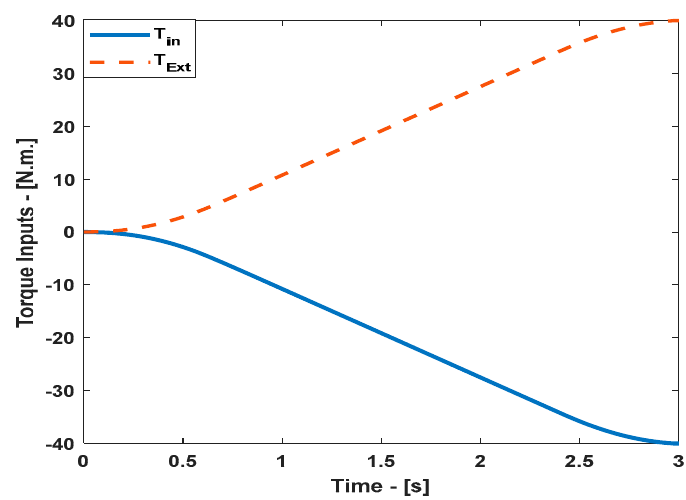
Figure 9. The input signals for the CTC scheme when all the clutches are active ( K eq = 7 K 0 ) for the entire simulation time.